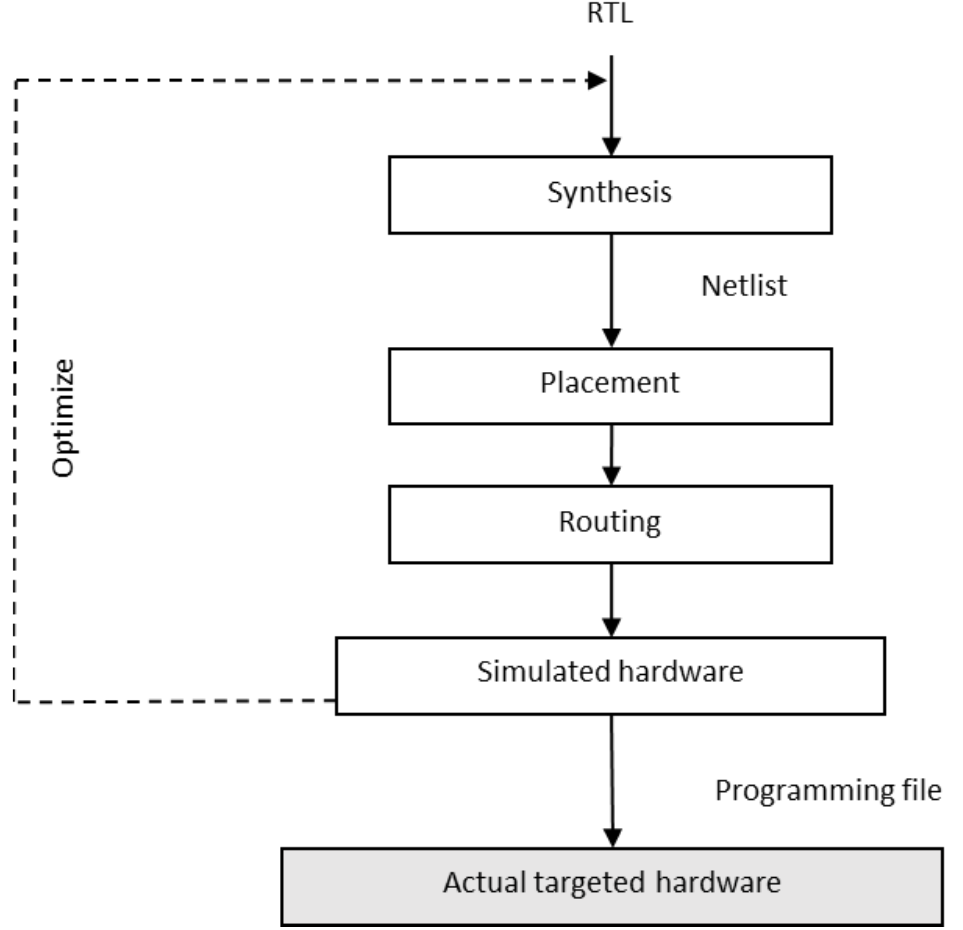
Figure 6. Steps in FPGA.